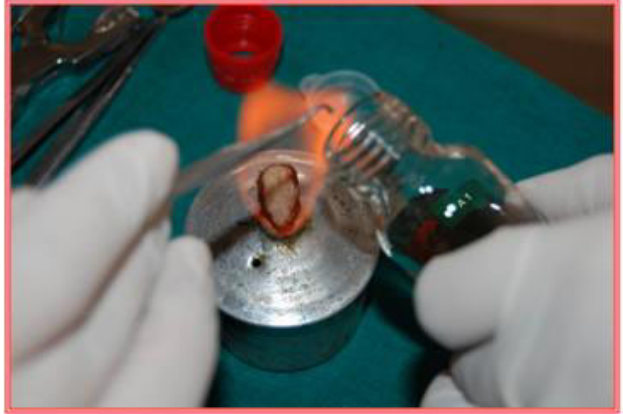
Fig. 2 - Pretreatment collection of sample for microbiological evaluation